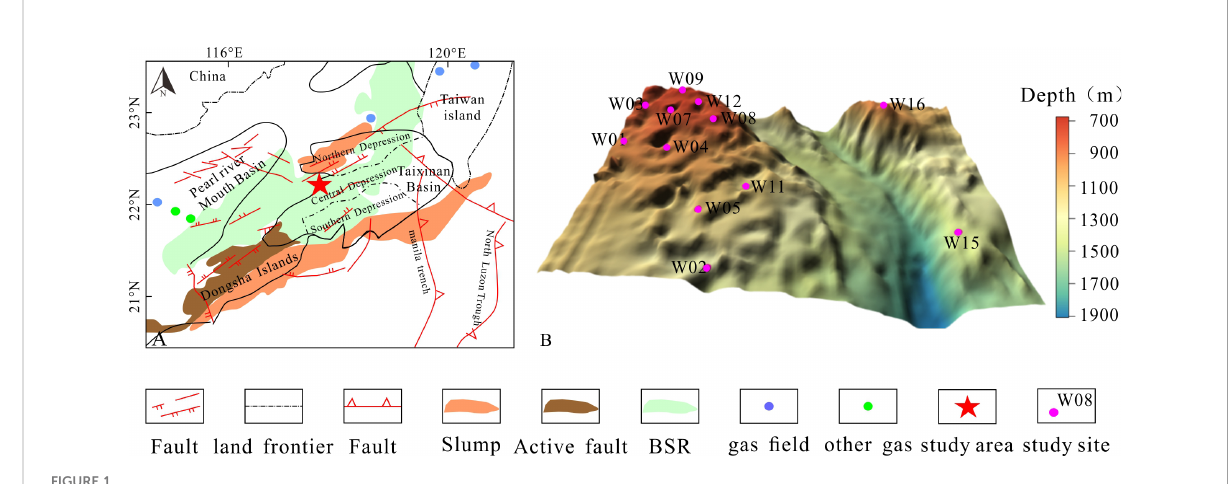
FIGURE 1 Geographic location and coring site characteristics of the Dongsha region. (A) Tectonic units of the southwest Taiwan Basin (data resource: Li et al., 2020). (B) Seawater depth and location characteristics of coring sites in the Dongsha